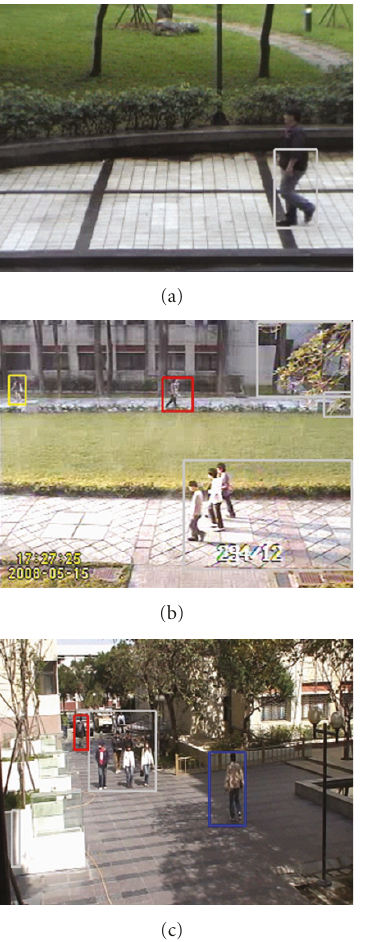
Figure 21: The negative examples in human